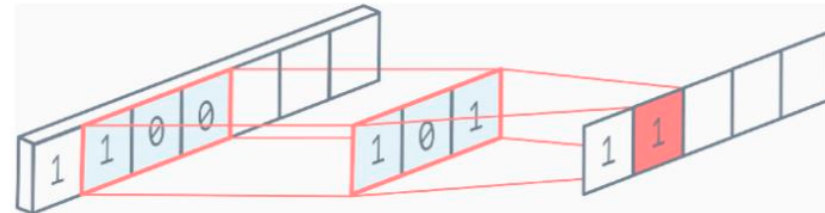
Figure 9. 1D Figure 9. 1D convolution.